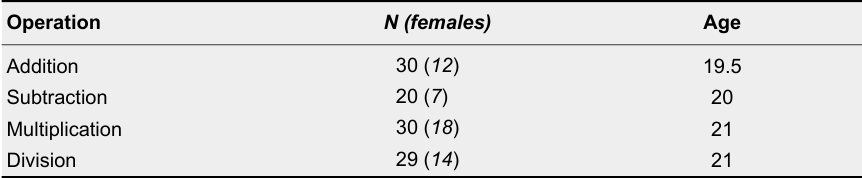
Demographic Information About the Participants for Each of the Four Operations